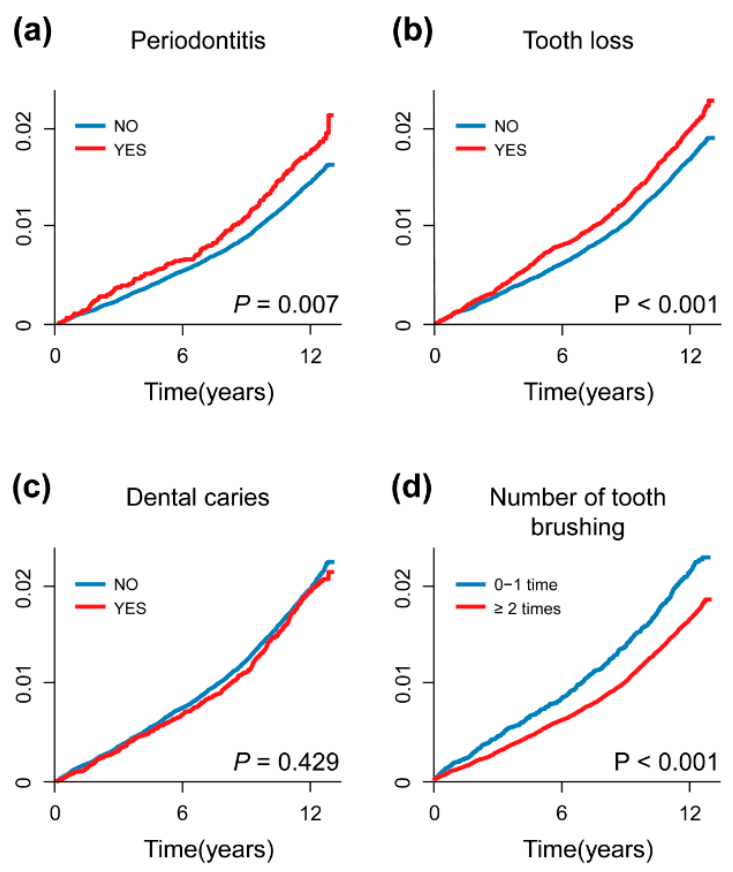
Figure 2. Cumulative incidence curves for the occurrence of retinal vascular occlusions. The occur- rence of retinal vascular occlusions increased with the presence of periodontitis, tooth loss, and a lower frequency of daily tooth brushing. X-axis: time (years), Y-axis: cumulative incidence of retinal vascular occlusion. Table 2. Risk factors for the occurrence of retinal vascular